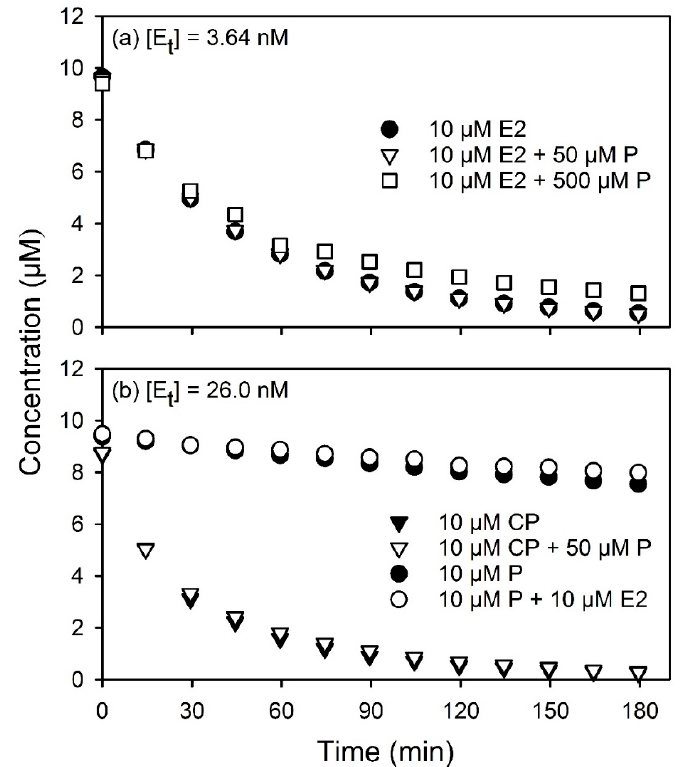
Figure 2. Residual concentrations of individual and mixed substrates over 3-h reaction periods: ( a ) effects of 50 and 500 μ M phenol (P) on reactions of 10 μ M estradiol (E2) with 3.64 nM laccase; ( b ) effect of 50 μ M phenol (P) on the reaction of 10 μ M cumylphenol (CP) and effect of 10 μ M estradiol (E2) on the reaction of 10 μ M phenol (P) with 26 nM laccase.